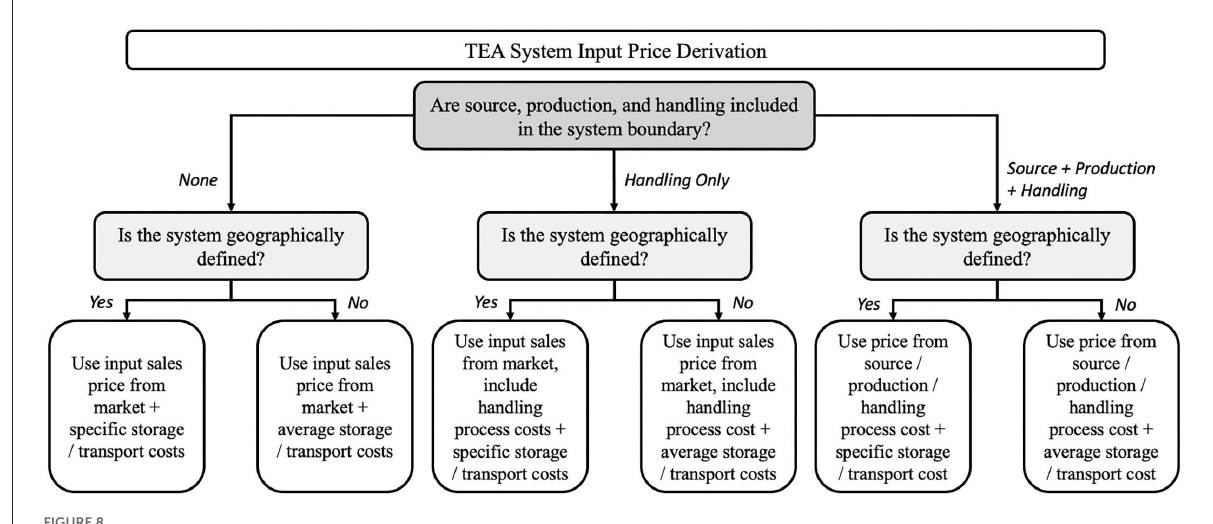
FIGURE8 Derivation of commodity input prices as a function of system boundaries. Adapted from the Global CO 2 Initiative (Zimmermann et al.,